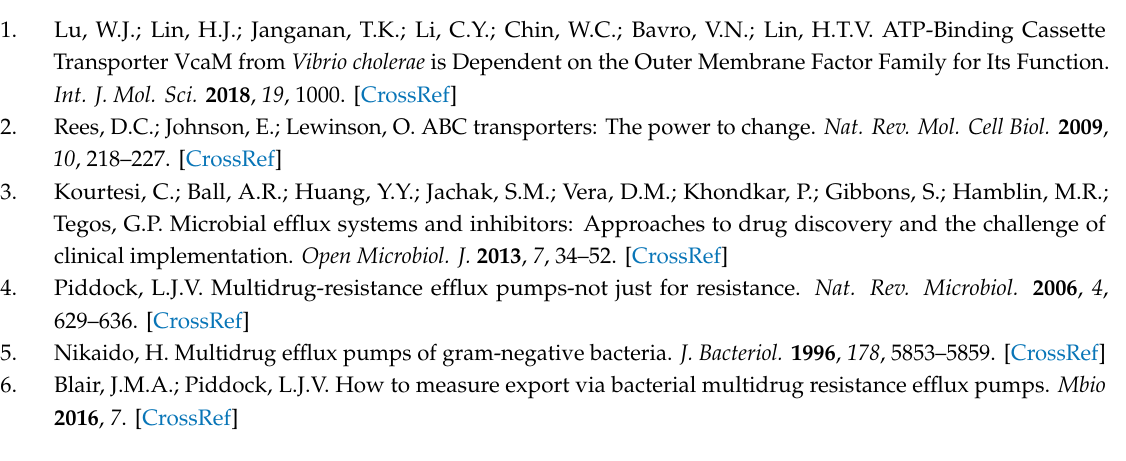
Figure S1: Identification of the purified AcrB protein, Figure S2: The influx and e ffl ux of the substrates when they are incubated with the E. coli cells, Figure S3: The calibration curves of dyes, Figure S4. The calibration curves of drugs, Table S1: The IC 50 of Kam3, and Kam3-AcrB against dyes and